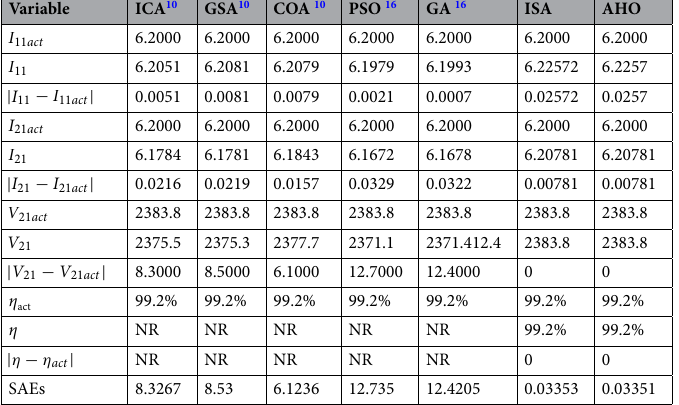
Table 2. Comparison between the proposed AHO optimizer and other optimizers for 15 kVA transformer. NR not reported.